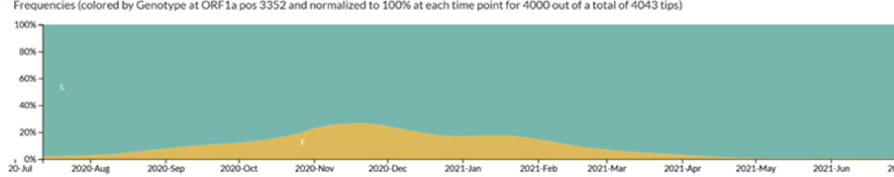
Fig 4. Frequency of a CUAF clade 20G mutation in North America between March 2020 and June 2021. The mutation pictured here is from ORF1A, genomic position 10319, amino acid position